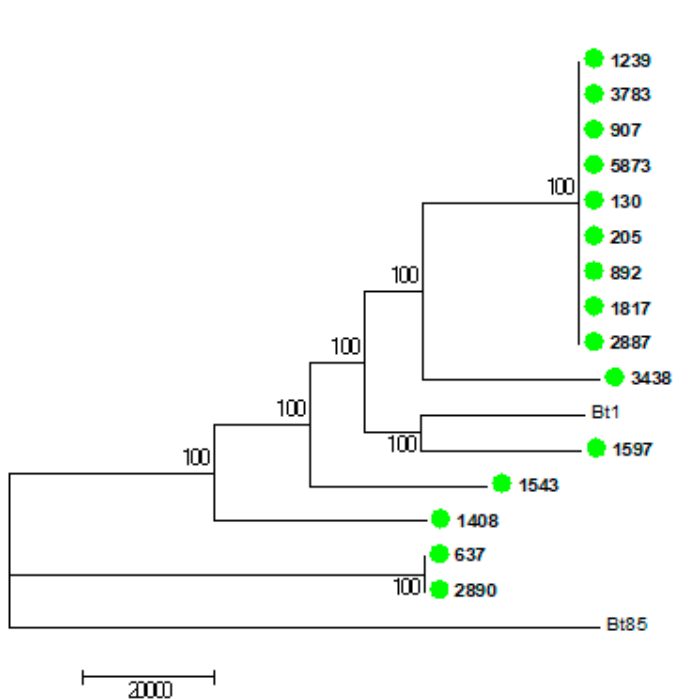
Figure 3. Whole genome sequencing single nucleotide polymorphism (WGS SNP) analysis of 15 South African clinical Cryptococcus neoformans isolates with the VNB molecular type (green circles and bold). Bt 85 (VNBI) was used as the reference and Bt 1 (VNBII) was added as an external genome. BWA was used to align reads to the reference and SAMtools was used to call SNPs. There were 293,484 SNPs in total with a coverage breadth of 88% and this is a midpoint-rooted maximum parsimony tree with 500 bootstrap replicates. The bootstrap values are shown next to the branches, the consistency index was 0.65, and the number of phylogenetic sites was 293,484.